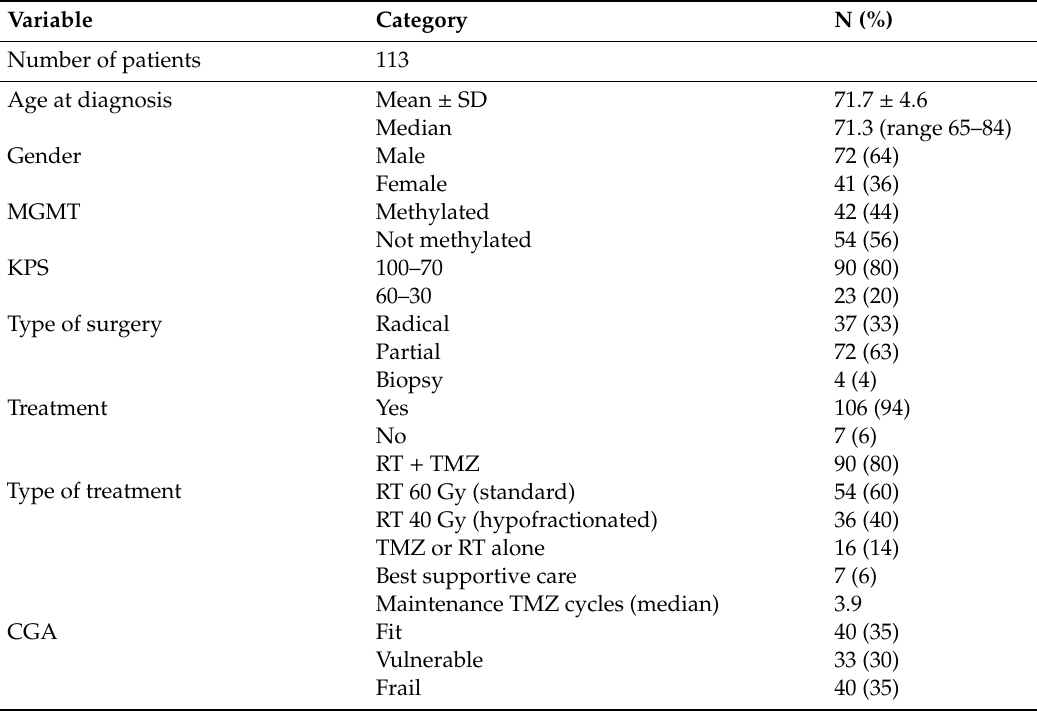
Table 1. Baseline characteristics of patients.